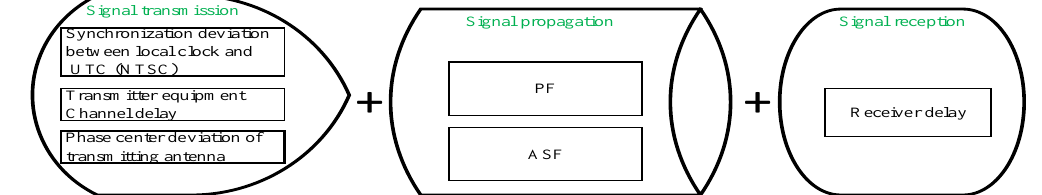
Figure 3. The entire propagation delay is composed of transmission delay, signal propagation delay and signal receiving delay. The signal propagation consists of the primary factor (PF) and the additional secondary factor(ASF).